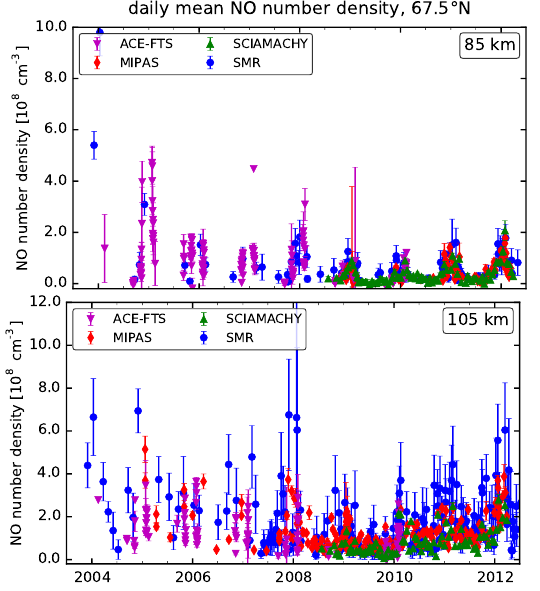
Figure 3. NO time series comparison of all four instruments at 67.5 ◦ N, for 85km (top) and 105km (bottom). The error bars indi- cate the statistical 95% confidence interval of the daily zonal mean.